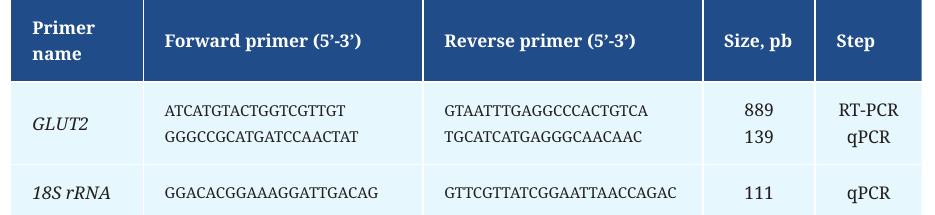
TABLE 1 | Oligonucleotides used for glut2 gene sequencing and q-PCRs in Petenia splendida